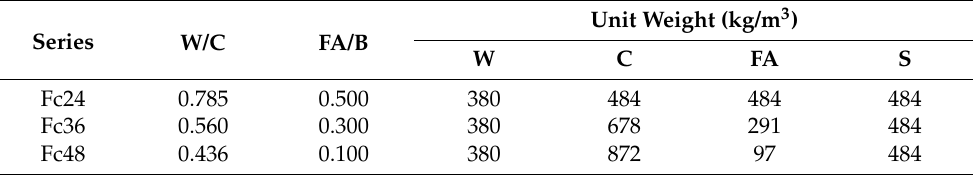
Table 2. Matrix mixture